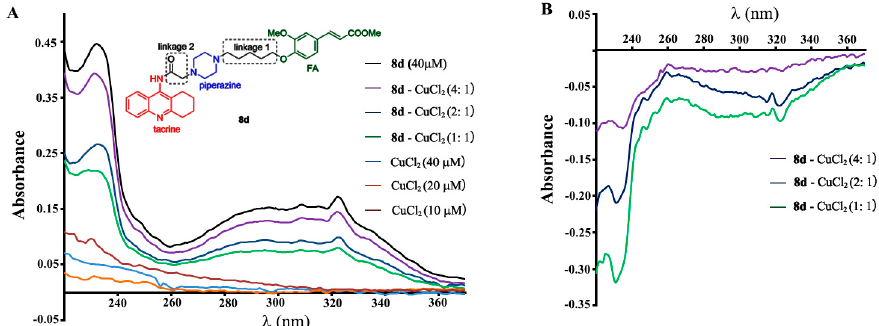
Figure 2. ( A ) UV (220–400 nm) absorption spectra of 8d (40 μ M) with 10, 20 or 40 μ M CuCl 2 in MeOH. ( B ) The differential spectra due to 8d -CuCl 2 complex formation obtained by numerical subtraction.